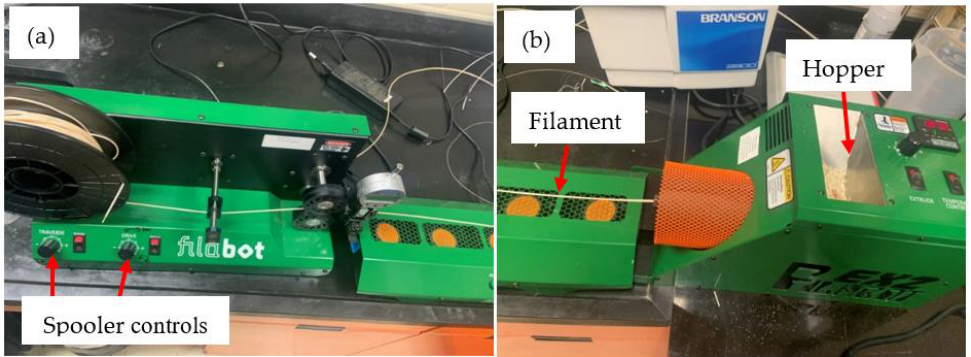
Figure 1. Filament extrusion apparatus: ( a ) Filabot spooler; and ( b ) Filabot extruder.